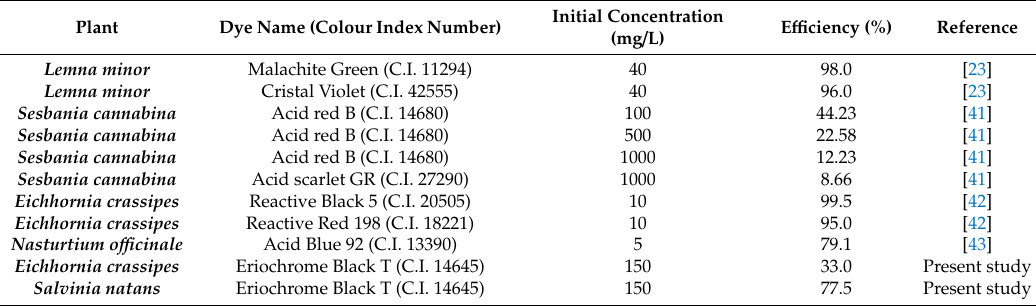
Table 3. Comparison of phytoremediation e ffi